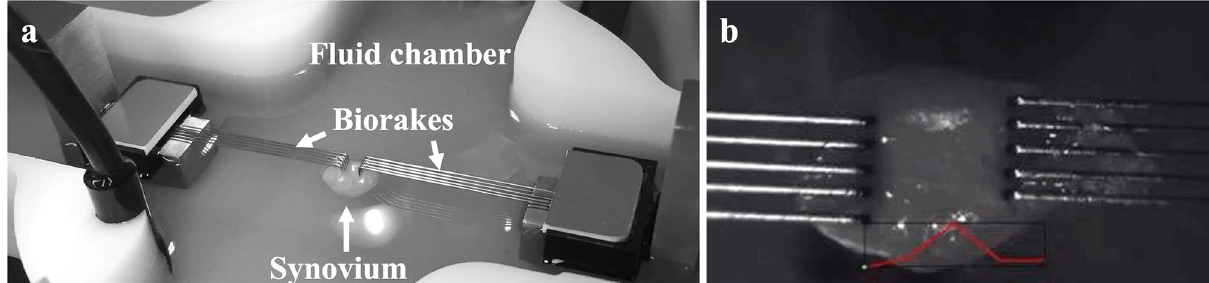
Figure 4. Synovial cyclic tensile strain experimental set up. ( a ) Representative image of synovial tissue sample loaded on CellScale BioTester apparatus. ( b ) Close up image of synovial tissue attached to Biorakes with strain displacement graph